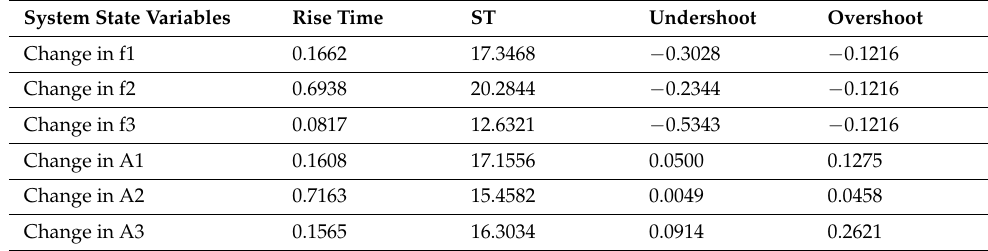
Table 4. Transient response of AGC performance evaluation for without controller.